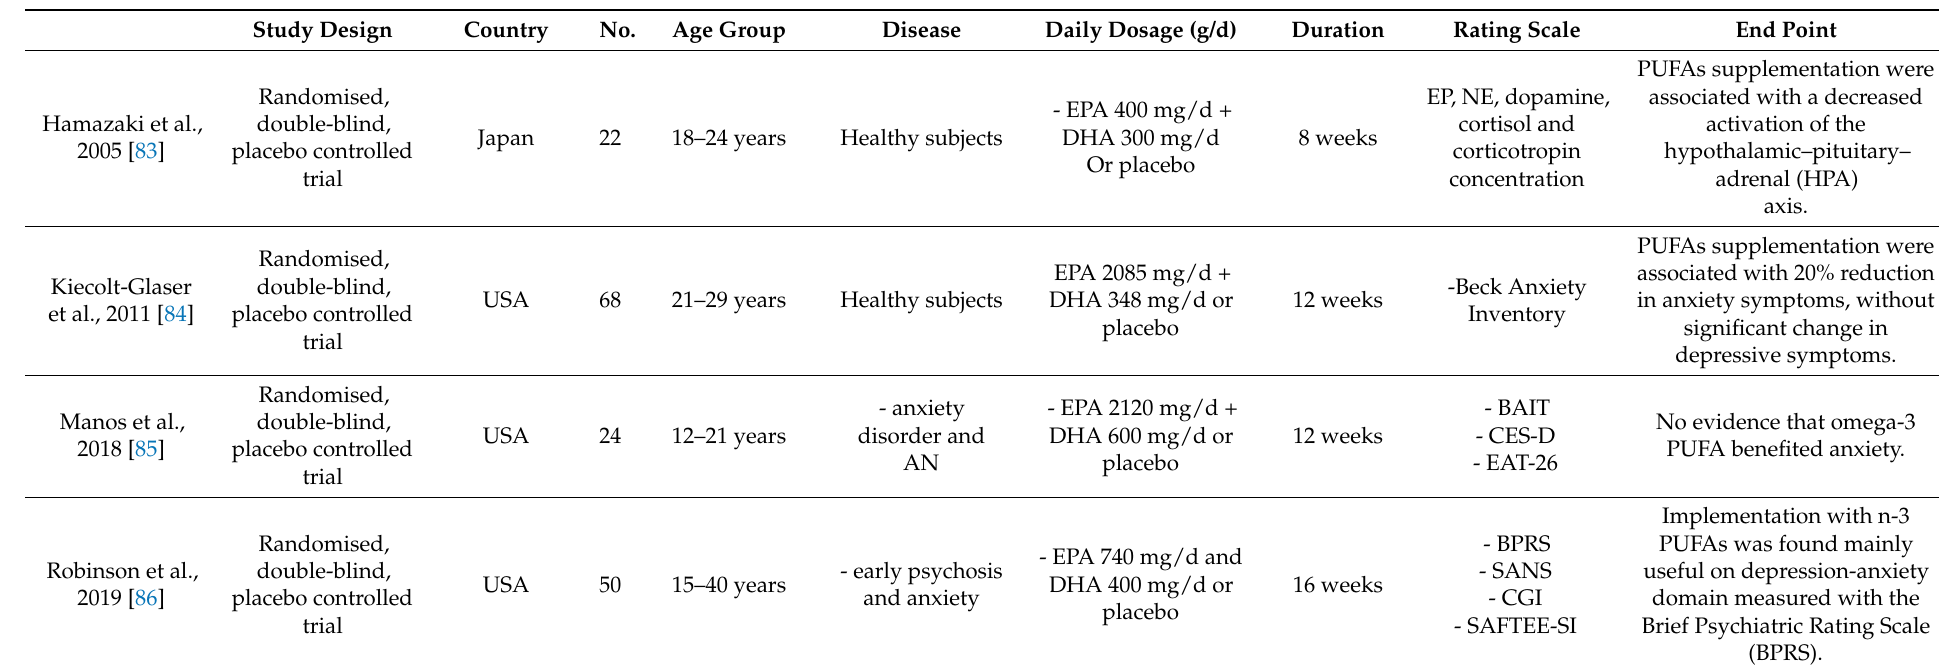
Table 4. Anxiety